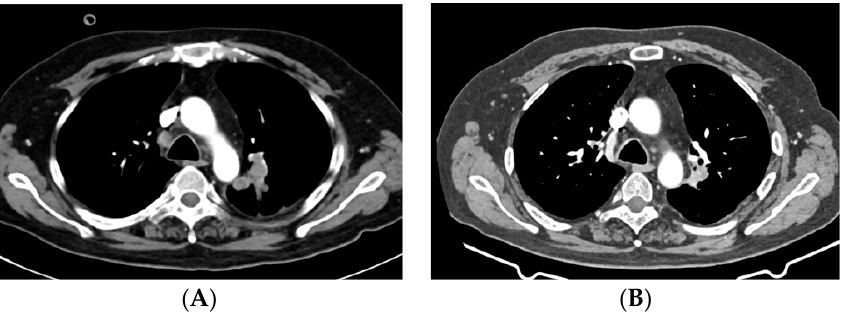
Figure 7. CT scan shows a left hilar lung lesion before start of EV (( A ), 43 mm) and after 3 cycles of EV (( B ), 23 mm). Abbreviations: CT, computed tomography; EV, enfortumab